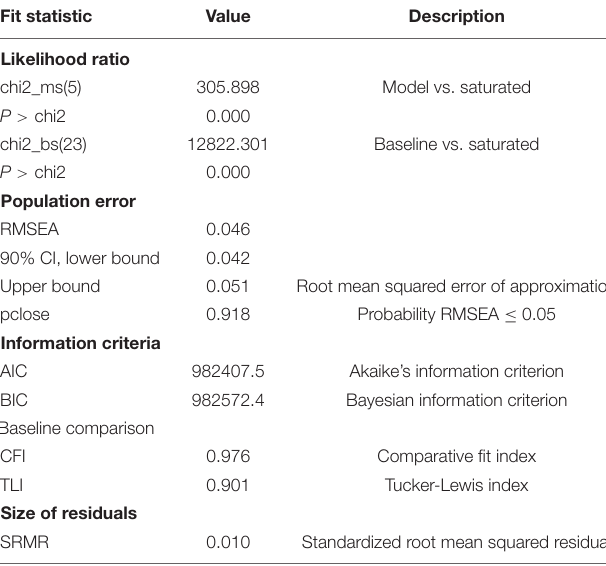
TABLE 5 | Fit statistic of the model.